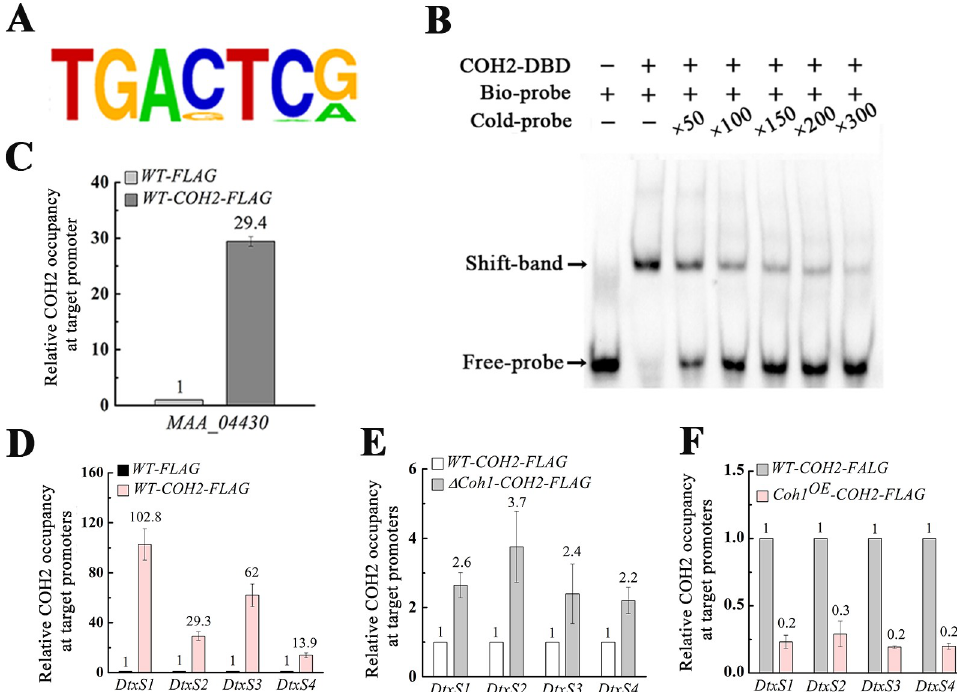
Fig 4. Identification of hemocoel-colonizing genes regulated by COH1 and COH2. (A) Chromatin immunoprecipitation sequencing (ChIP-Seq) analysis identified the DNA motif COH2-BM that was bound by the transcription factor COH2. (B) Electrophoretic mobility shift assay (EMSA) confirms the in vitro binding of the biotin- labeled motif COH2-BM (Bio-probe) to the recombinant protein COH2-DBD (COH2 DNA binding domain). The binding activity was demonstrated by the shift of the labeled DNA band prior to the addition of the specific competitor (Cold-probe: the unlabeled motif COH2-BM ) in 50-, 100-, 150-, 200-, or 300-fold excess. The tested DNA motif COH2-BM is from the promoter of the gene MAA_04430, which was shown to have the motif COH2-BM by the ChIP-Seq analysis. (C) Chromatin immunoprecipitation quantitative PCR (ChIP-qPCR) analysis confirms that COH2 in vivo binds to the motif COH2-BM in the MAA_04430 promoter in the strain WT-COH2-FLAG , expressing the fusion protein COH2::FLAG. WT-FLAG : a strain expressing the tag FLAG only. (D) ChIP-qPCR confirmation of the in vivo binding of COH2 to the promoters of the 4 destruxin biosynthesis genes ( DtxS1 , DtxS2 , DtxS3 , and DtxS4 ). (E) ChIP- qPCR analysis shows that during surrogate hemocoel colonization, deleting the Coh1 gene increased the binding of COH2 to the promoters of the 4 destruxin biosynthesis genes. Δ Coh1-COH2-FLAG : a strain expressing the protein COH2::FLAG in the mutant Δ Coh1 . (F) ChIP-qPCR analysis confirms that during saprophytic growth, COH1 reduced the in vivo binding of COH2 to the promoters of the 4 destruxin biosynthesis genes. Coh1 OE -COH2-FLAG : a strain expressing the protein COH2::FLAG and overexpressing the Coh1 gene. The data underlying all the graphs shown in this figure can be found in S1